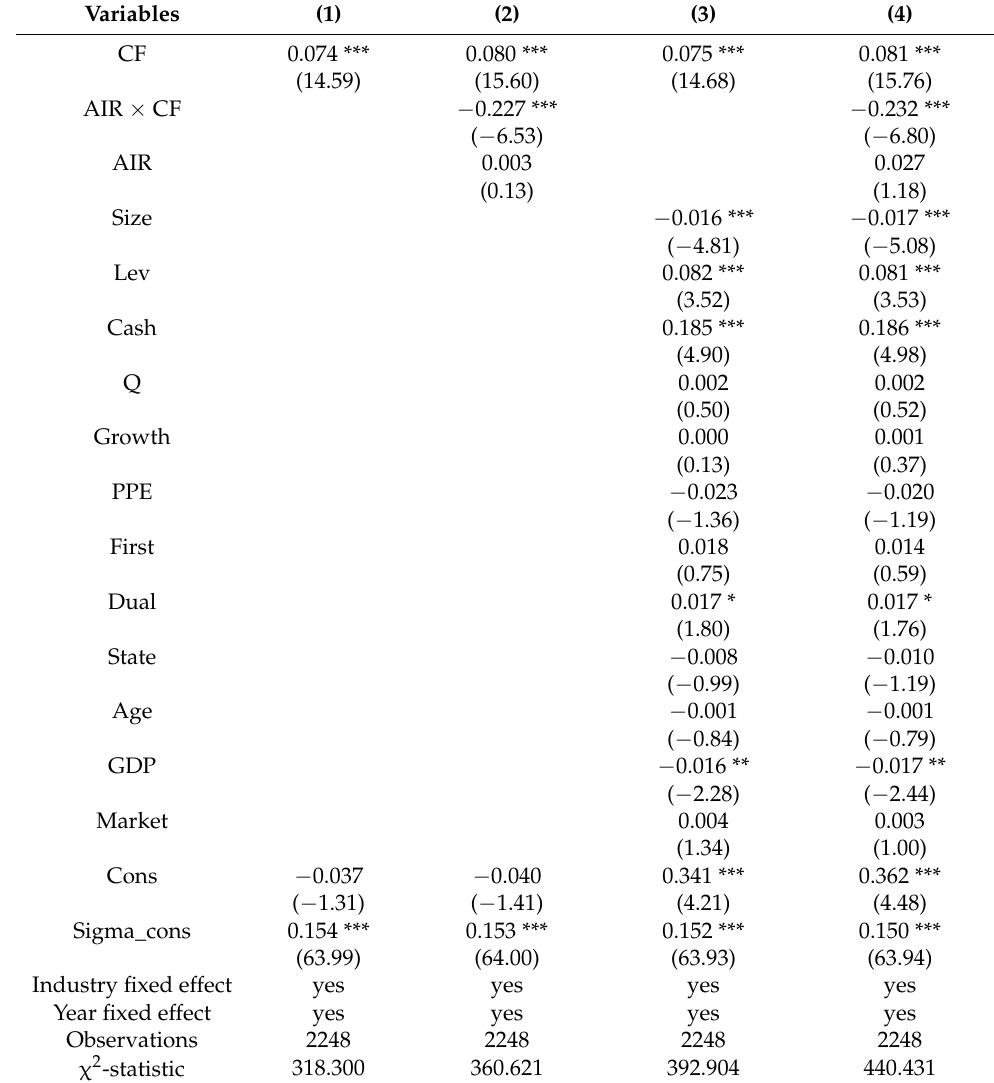
Table 5. The impact of air pollution on green financial constraint.